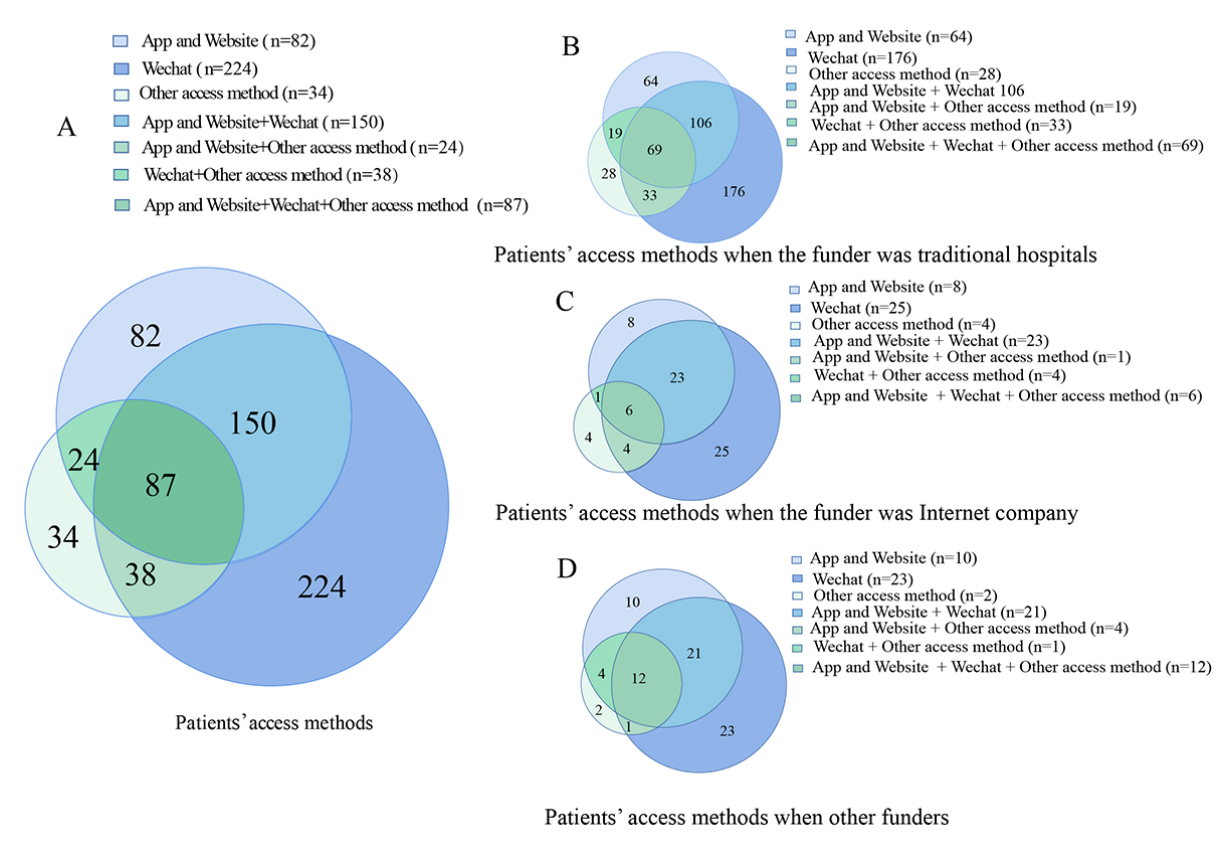
Figure 3. Methods for accessing internet hospitals. (A) Patients’ access methods. (B) Patients’ access methods when the funder was a traditional hospital. (C) Patients’ access methods when the funder was an internet company. (D) Patients’ access methods when the funder was another type of